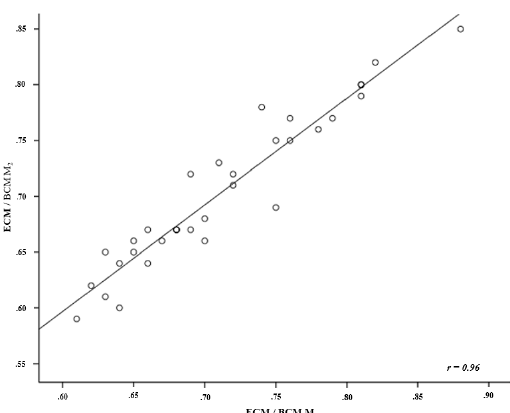
Figure 12. Correlation between the values of param- eters measured by Nutriguard-M before and after the intake of fluids – index ECM/BCM